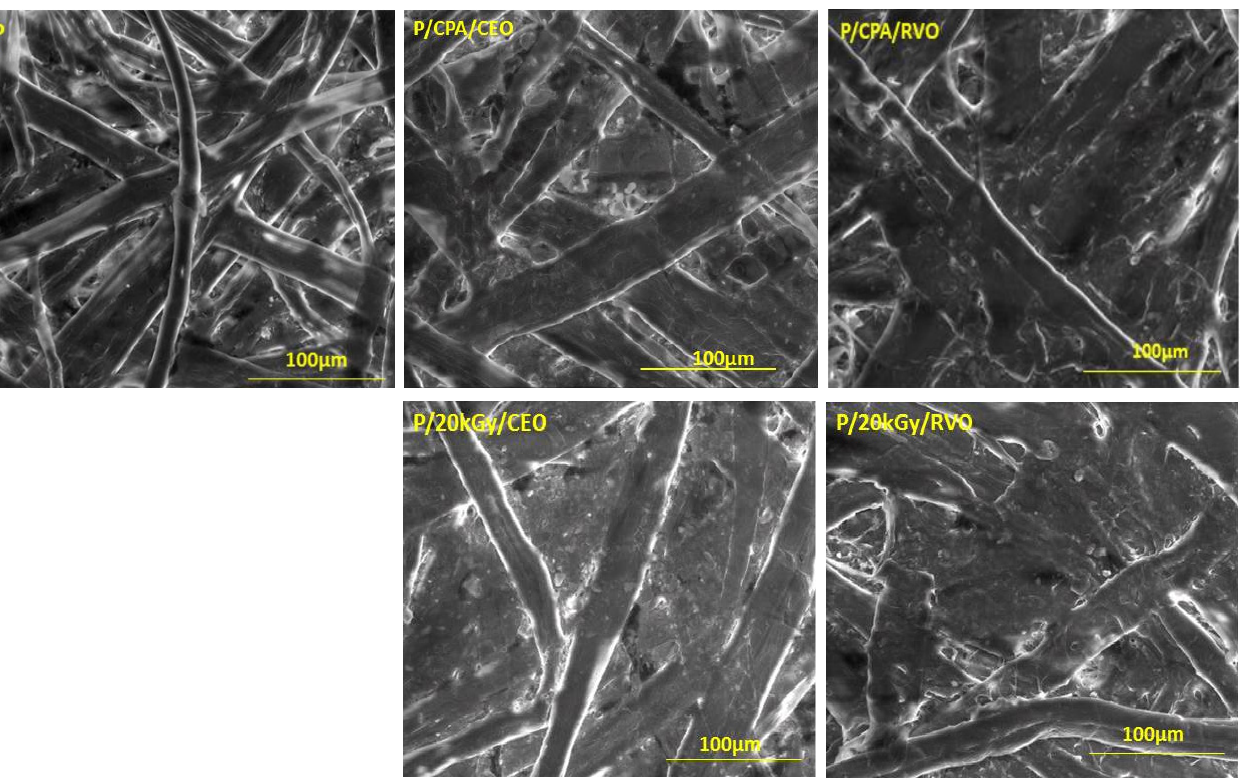
Figure 2. SEM images of the obtained samples.